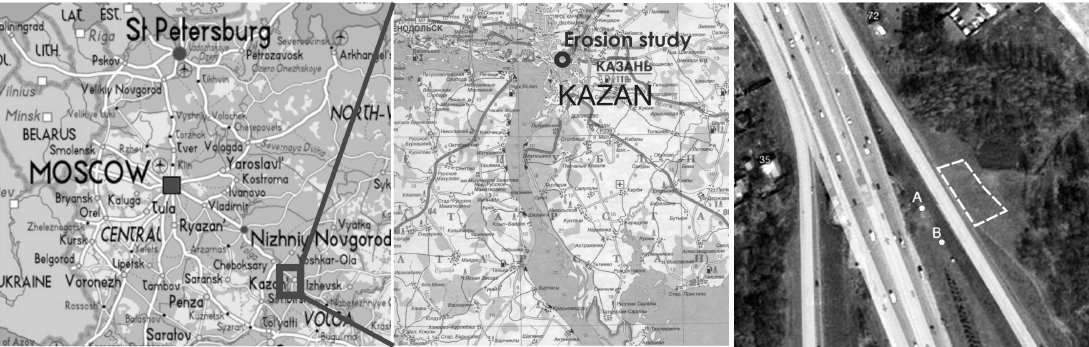
Fig. 1 Investigated area (A and B are the scanner